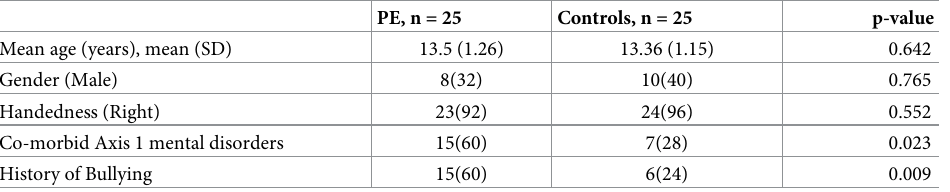
PE, n = 25 Controls, n = 25 p-value Mean age (years), mean (SD) 13.5 (1.26) 13.36 (1.15) 0.642 Gender (Male) 8(32) 10(40) 0.765 Handedness (Right) 23(92) 24(96) 0.552 Co-morbid Axis 1 mental disorders 15(60) 7(28) 0.023 History of Bullying 15(60) 6(24)